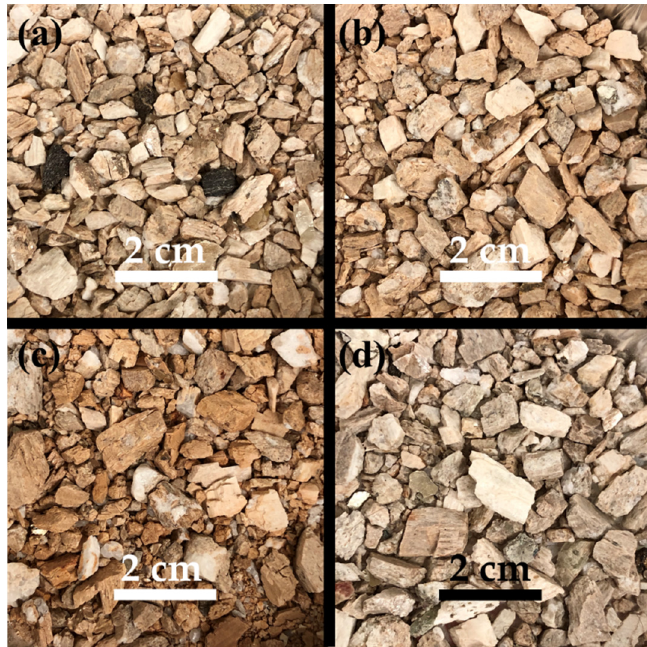
Figure 4. Concentrates obtained after low temperature thermal treatment: ( a ) sample B, 1073 K (800 °C), 1 h; ( b ) sample C, 1148 K (875 °C), 1 h; ( c ) sample D, 1223 K (950 °C), 1h; and ( d ) sample E, 1123 K (850 °C), 6 h.